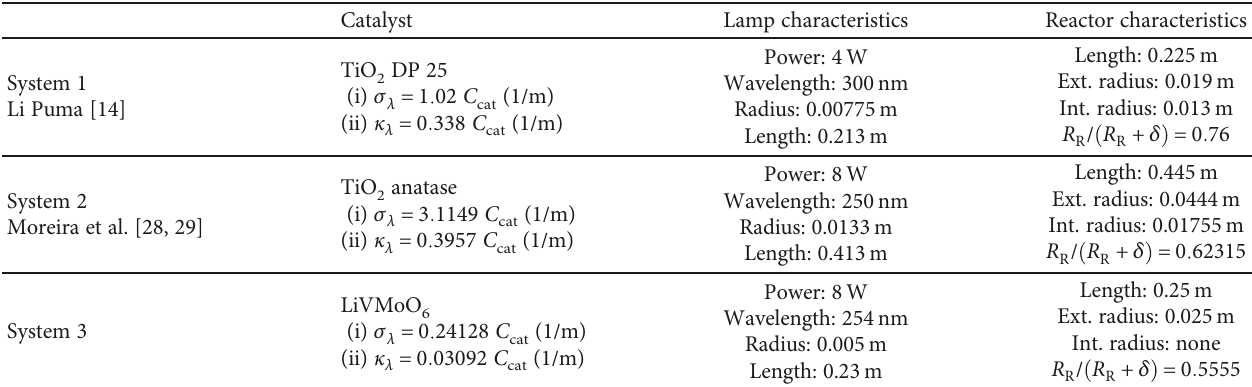
Table 1: Characteristics of